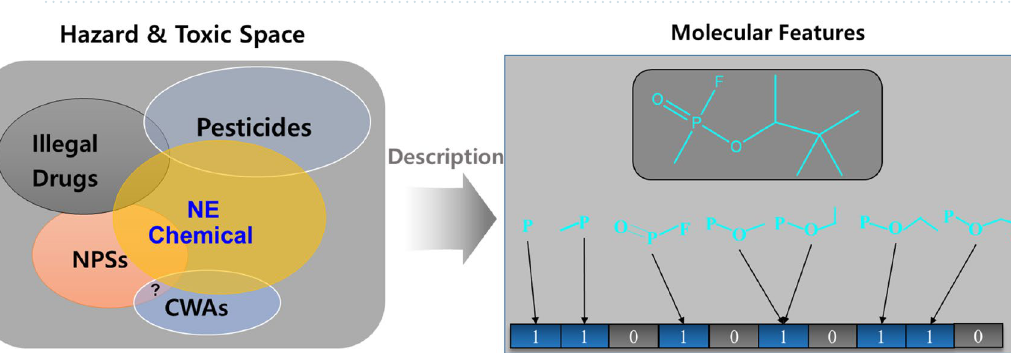
Figure 1. Chemical threats include chemical warfare agents (CWAs) having assigned NATO codes, CWA stimulants, new psychoactive substances (NPSs) and chemical hazards such as PHMG (sterilizer) and TCDD.